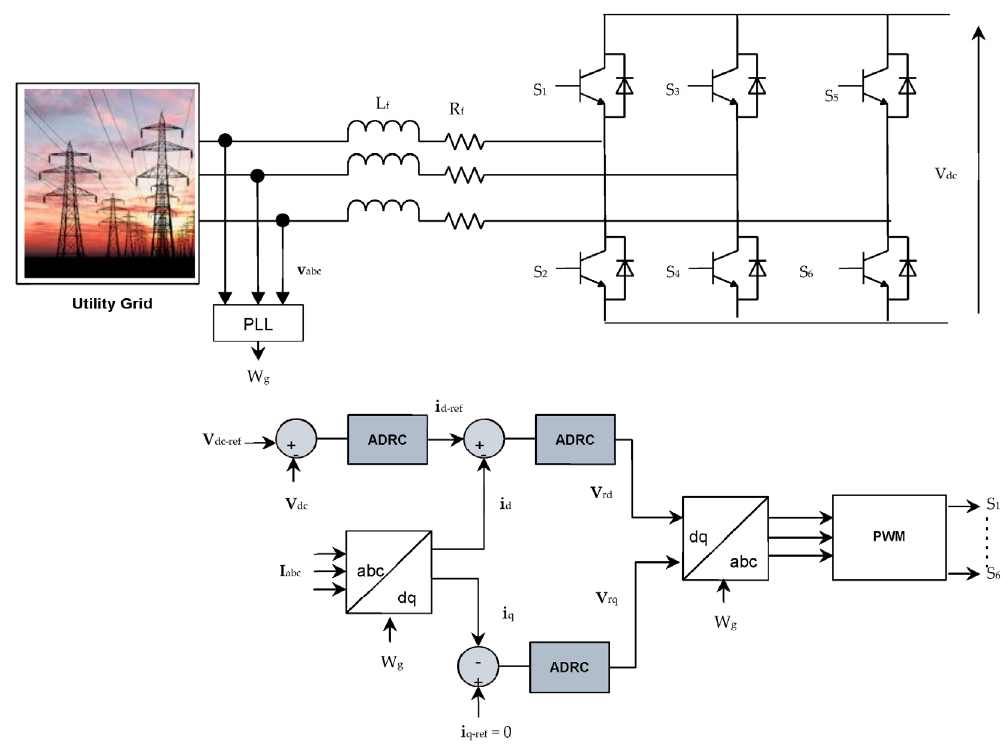
Figure 5. The grid-side converter control design.